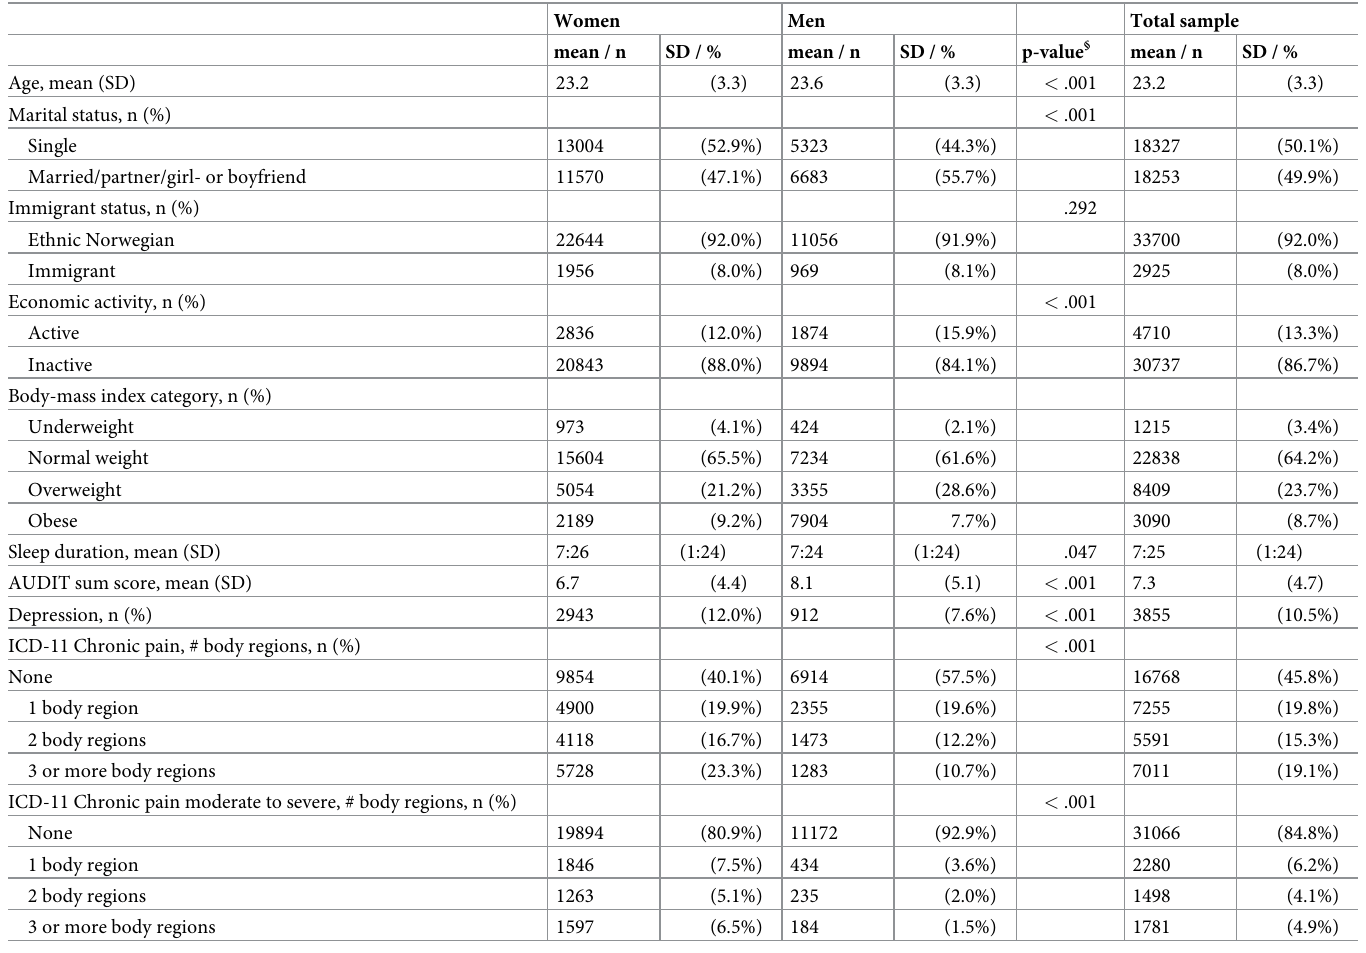
Table 1. Sociodemographic and clinical characteristics of the study